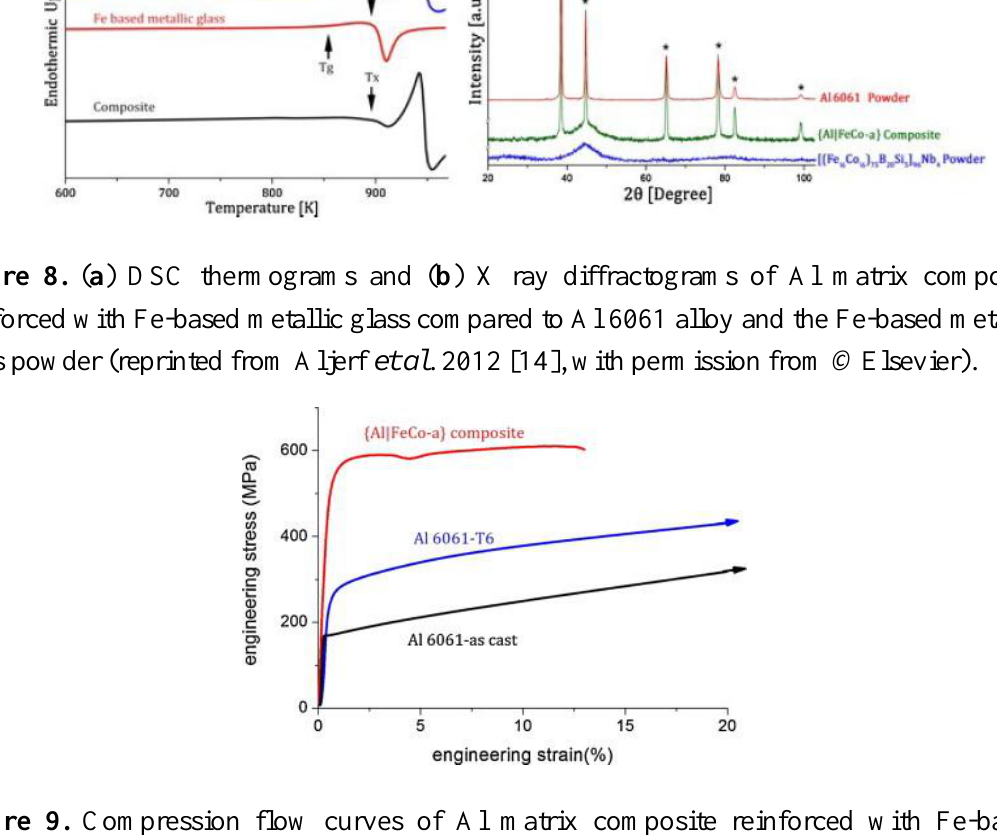
Figure 9. Compression flow curves of Al matrix composite reinforced with Fe-based metallic glass compared to as cast and heat treated Al 6061 alloy (reprinted from Aljerf et al . 2012 [14], with permission from ©